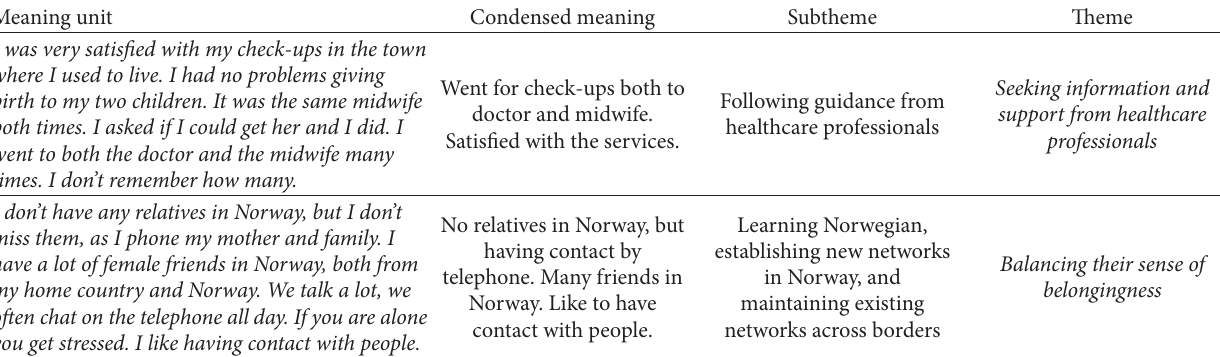
Table 2: Example of analysis: meaning unit, condensed meaning, subtheme, and